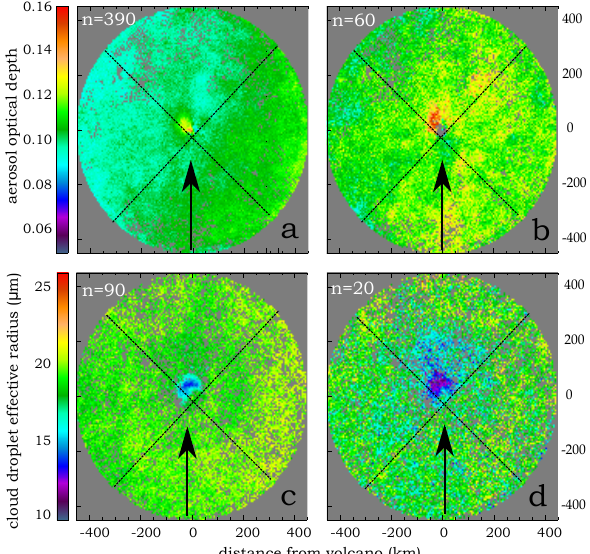
Figure 9. Scatterplots show the average of rotated MODIS Aqua Fig. 9. Scatterplots show the average of rotated MODIS Aqua AOD AOD (a, b) and CER (c, d) at Piton de la Fournaise during inter- (a & b) and CER (c & d) at Piton de la Fournaise during inter- eruptive (a, c) and eruptive (b, d) periods, 2002–2008. Cloud top eruptive (a & c) and eruptive (b & d) periods, 2002–2008. Cloud pressures are 860–440mb. The volcano summit is at (0,0) and ar- top pressures are 860–440 mb. The volcano summit is at (0,0) and rows indicate wind direction. Downwind is the upper quadrant in arrows indicate wind direction. Downwind is the upper quadrant in each case. n values refer to the average sample size in each image. each case. ‘n’ values refer to the average sample size in each im- Only data where sample sizes exceed 15 and relative standard devi- age. Only data where sample sizes exceed 15 and relative standard ations are less than 10% are deviations are less than 10% are shown.